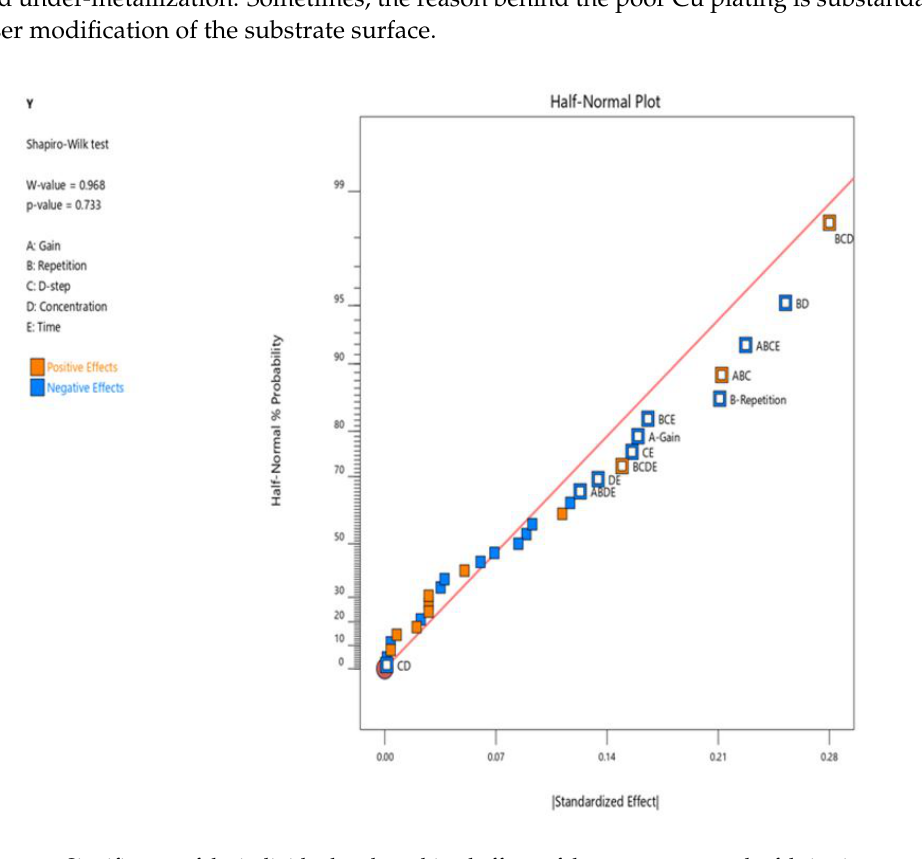
Figure 6. Significance of the individual and combined effects of the parameters on the fabrication